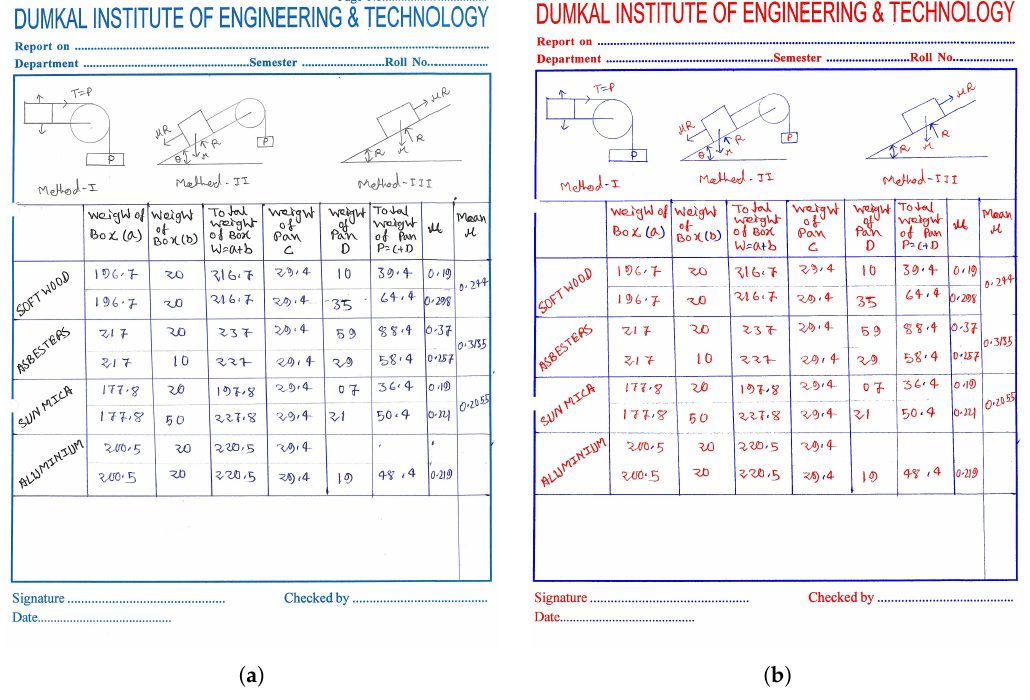
Figure 7. ( a ) sample image from our dataset; ( b ) ground truth of the given image (here, red represents text and blue represents non-text